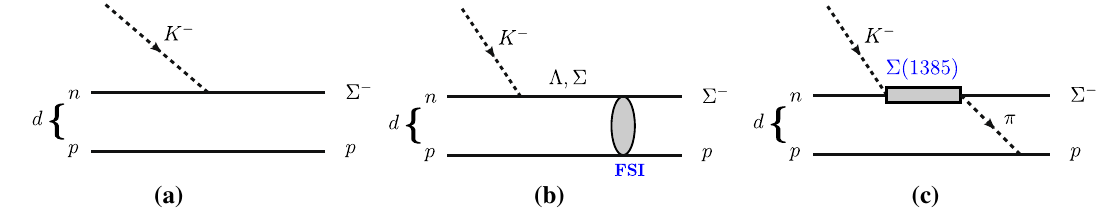
Fig. 13 Several alternative mechanisms that can produce the K − d → p Σ − ( p Σ − → K − d ) reaction: a impulse approximation, b